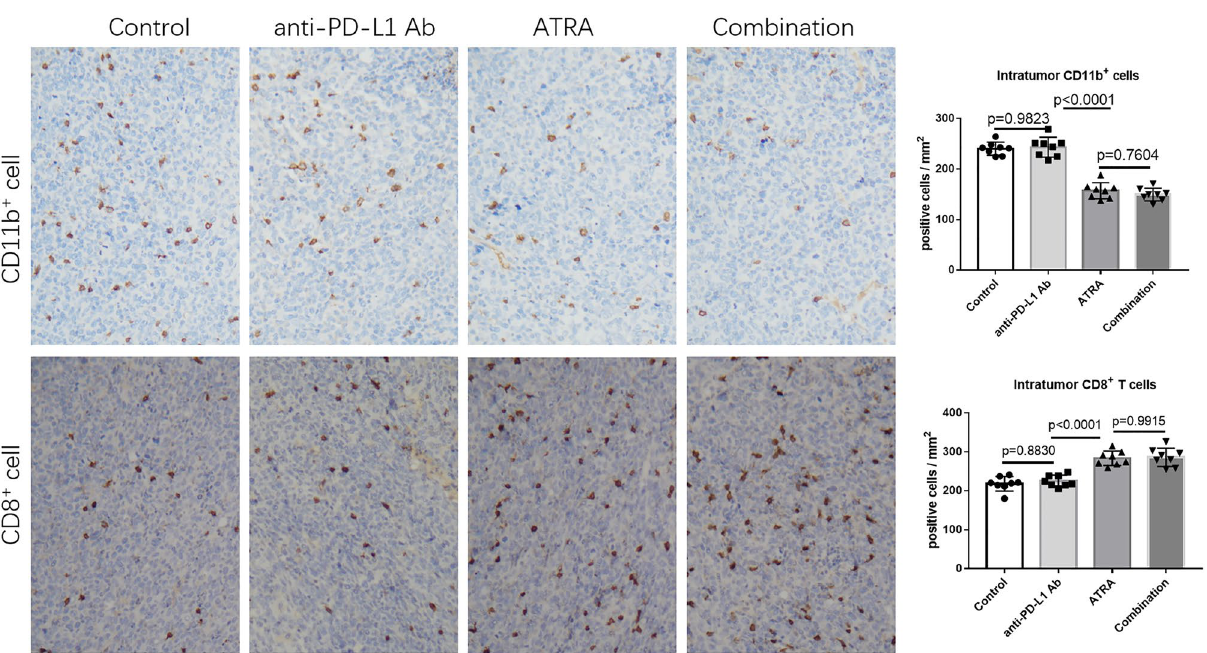
Figure 6. Change in CD11b + and CD8 + cells in tumor beds after treatment. Representative immunohistochemical images of CD11b + and CD8 + cells in the tumor beds from different groups (left) and the comparison of CD11b + cells and CD8 + T cells numbers in different groups (right). Data are shown as mean ± SD (8